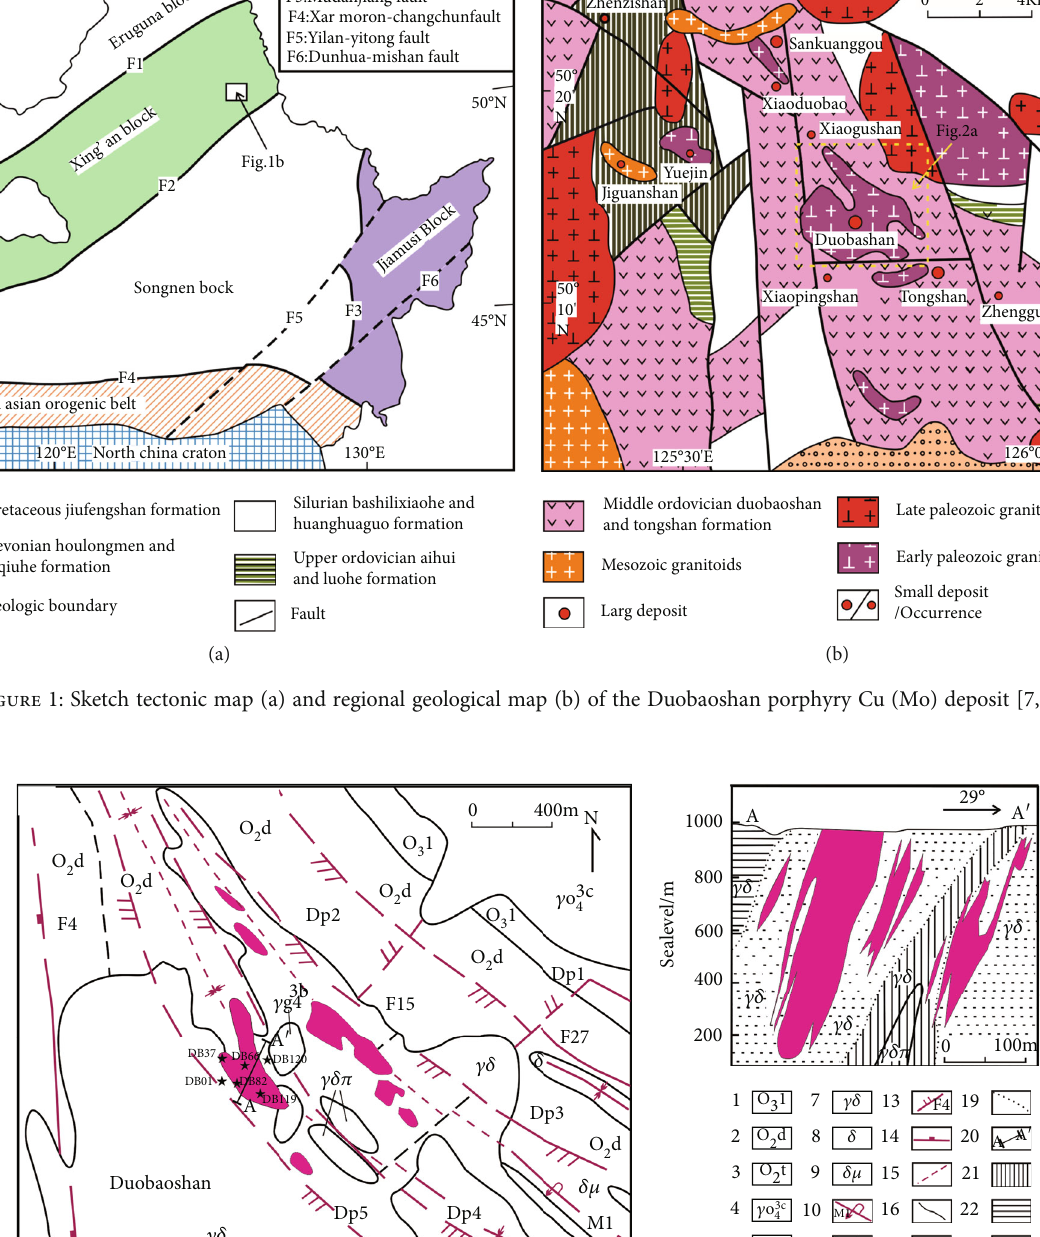
Figure 2: Simpli fi ed geological tectonic map (a) and schematic section of ore belt No. 3 (b) of the Duobaoshan porphyry Cu (Mo) deposit [9, 18]. 1-Luohe Formation; 2-Duobaoshan Formation; 3-Tongshan Formation; 4-Plagiogranite; 5-Trondhjemite; 6-Granodiorite porphyry; 7-Granodiorite; 8-Diorite; 9-Diorite porphyrite; 10-The inverted anticline and its serial number; 11-Synclinal axis; 12-Compression- torsional arc fracture fragmentary zone and Number; 13-Fault and Number; 14-Compression-torsional fault; 15-Field measurement and prediction of faults; 16-Observed geologic boundary; 17-Speculated geological boundary; 18-Ore body; 19-Alteration zone boundary; 20- Section line; 21-Potassic alteration zone; 22-Propylitic alteration zone; 23-Phyllic alteration zone; 24-Sampling